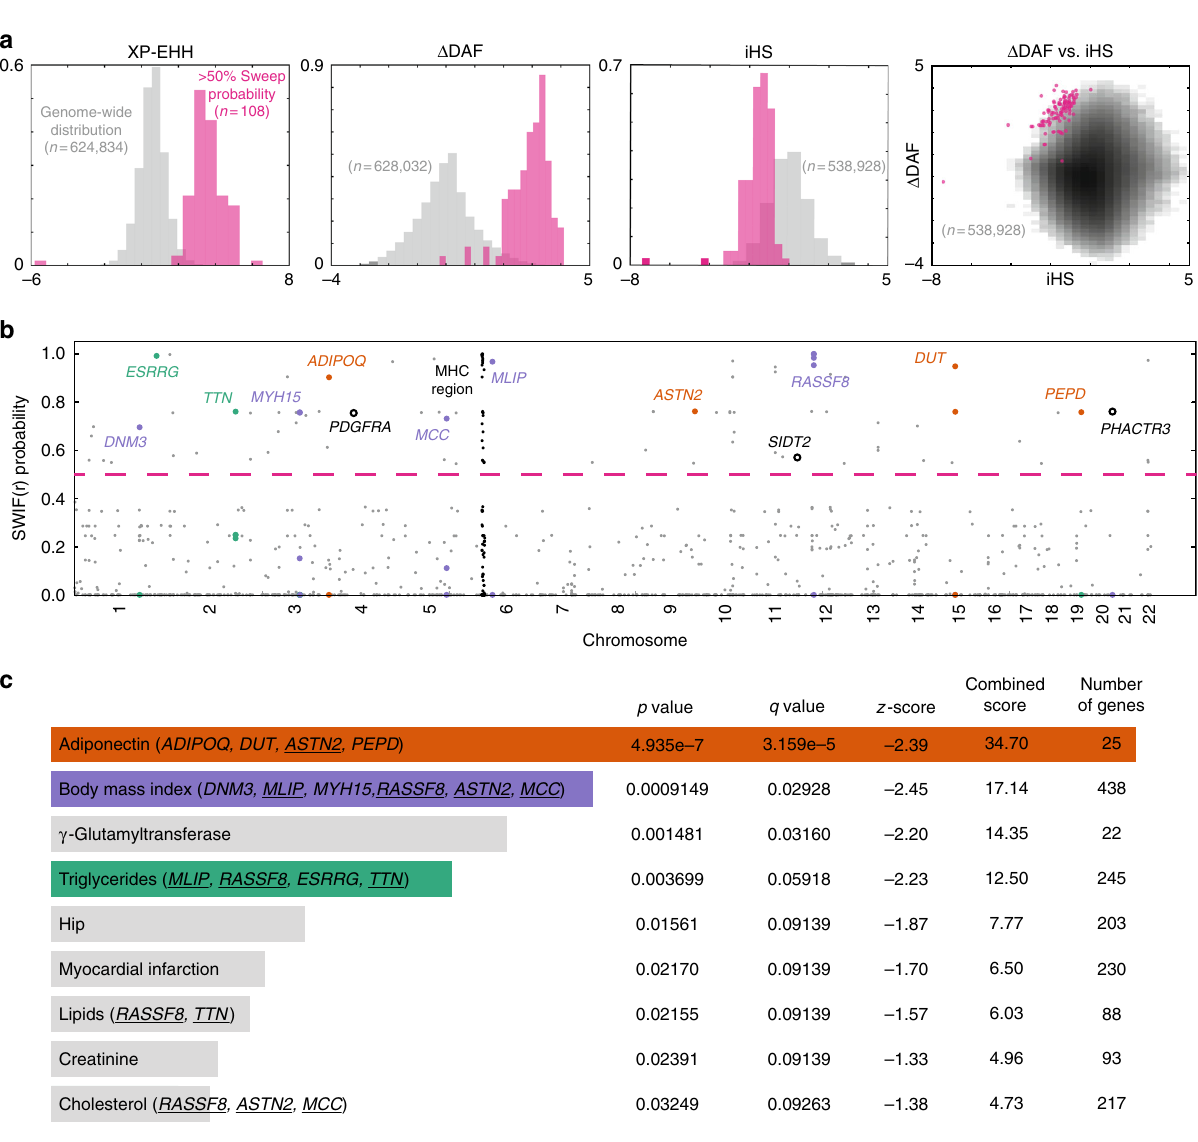
polymorphisms with differential allele frequencies between the ‡ Khomani San and other worldwide populations. One such gene is RASSF8 , previously annotated as under positive selection in the Namibian and ‡ Khomani San populations relative to western Africans using XP-EHH; 39 in our SNP array analysis, we detect a